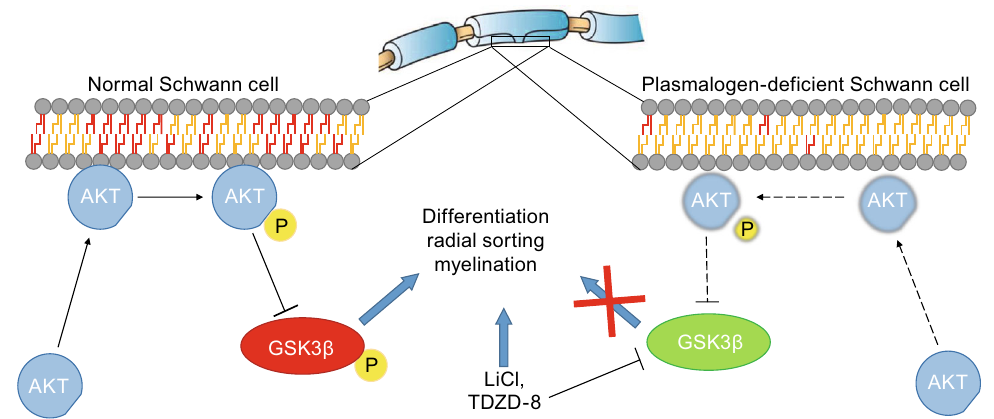
Figure 4. Role of ether lipids in Schwann cell differentiation and myelination. In a healthy Schwann cell, the cell membrane is enriched in plasmalogens. This is necessary for proper recruitment of Akt to the plasma membrane, resulting in its phosphorylation and activation. Activated Akt phosphorylates GSK3 β at Ser9, inhibiting its activity. Plasmalogen de fi ciency impairs recruitment and activation of Akt, preventing it ability to inhibit GSK3 β . Active GSK3 β impairs Schwann cell differentiation, resulting in disrupted radial sorting and myelination. Supplementation of lithium or TDZD-8 to inhibit GSK3 β rescues plasmalogen-de fi cient phenotype, restoring differentiation and